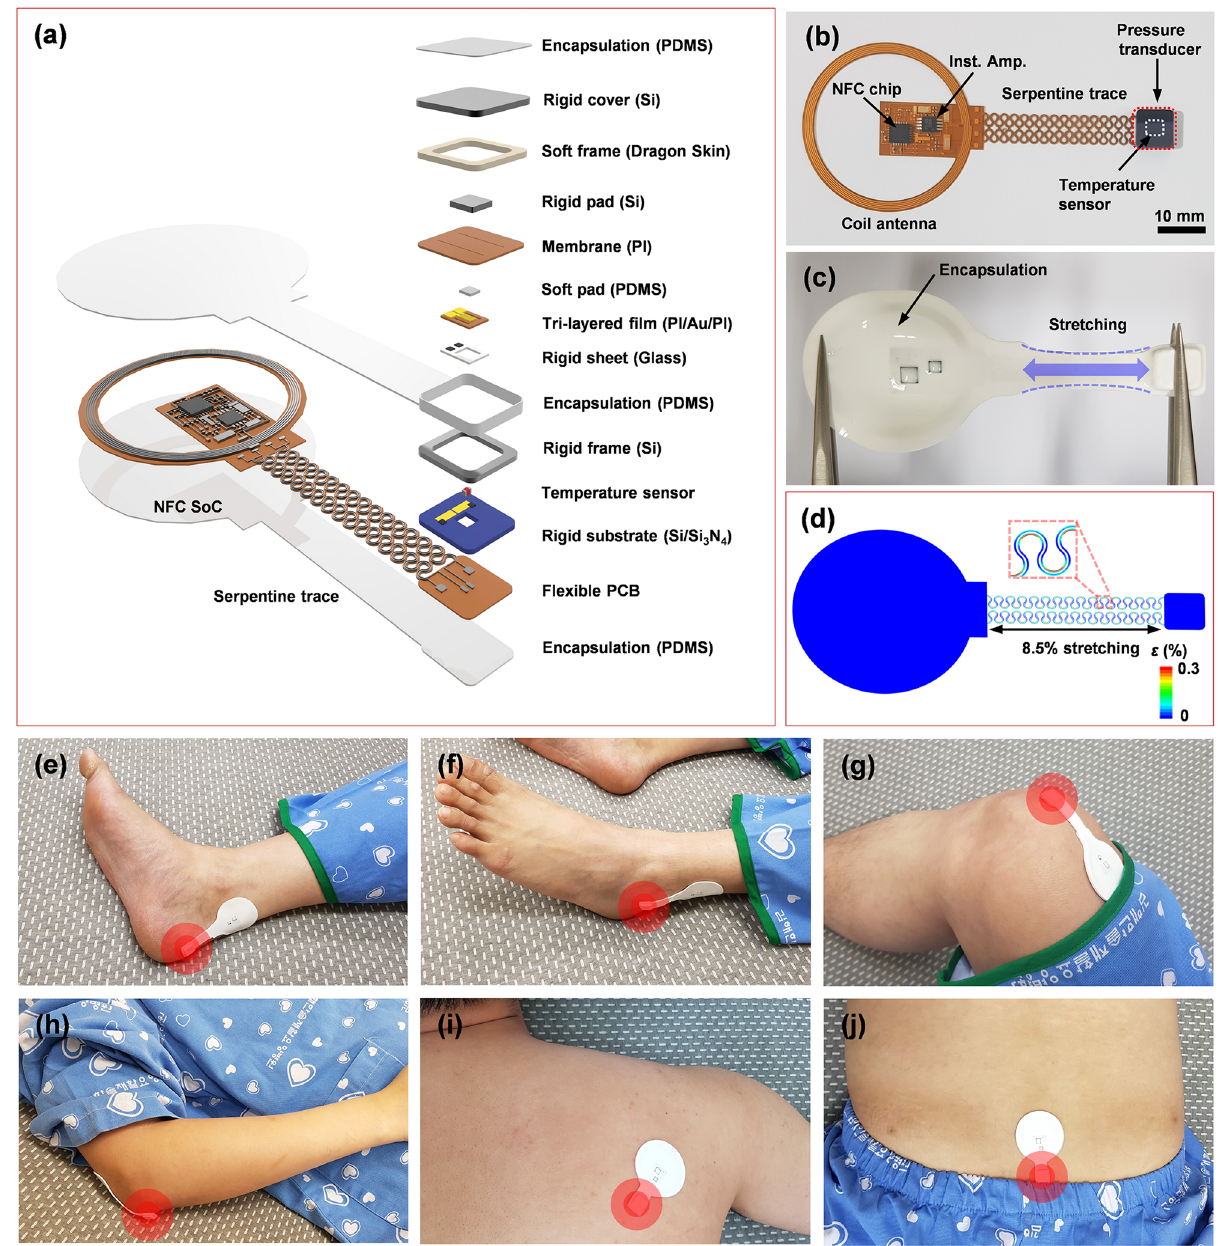
Fig. 1 Schematic illustrations and images of a battery-free, wireless pressure, and temperature-sensing platform. a Exploded view schematic illustration of the battery-free, wireless pressure and temperature-sensing platform. b Photograph of a device before packaging. c , d Photograph and FEA results for a packaged device in a stretched con fi guration. e – j Photographs of devices mounted on body locations that are susceptible to pressure injuries, including the heel, malleolus, knee, elbow, scapulae, and